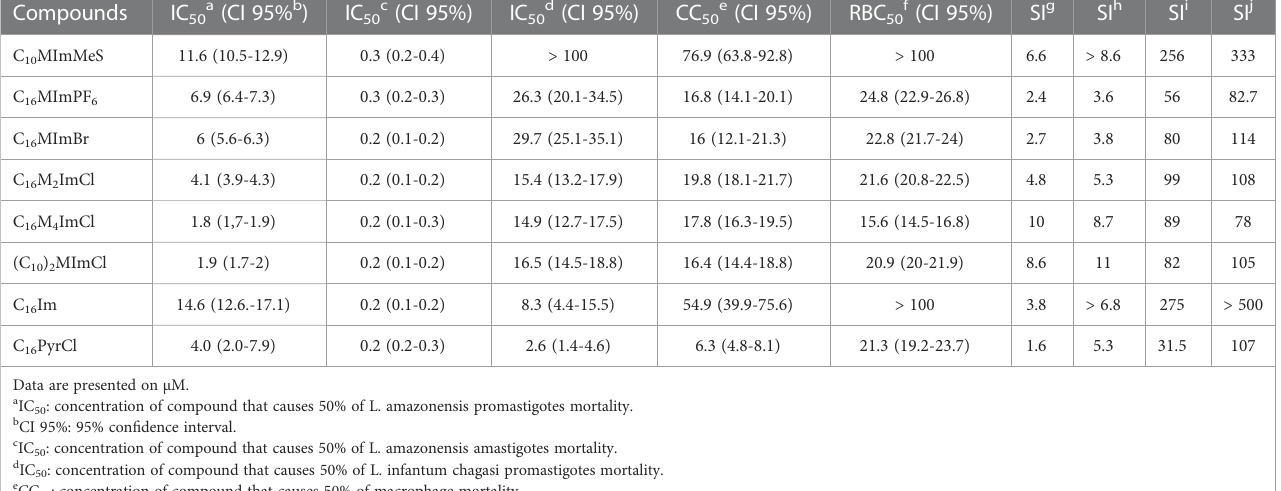
TABLE 1 Leishmanicidal activity, macrophage toxicity and hemolytic effect of compounds.